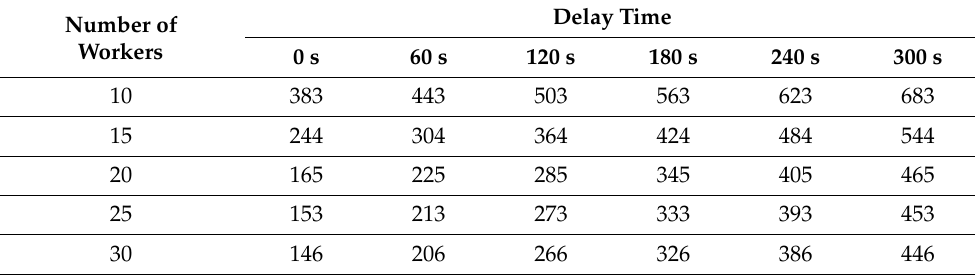
Table 7. Simulation results on required safe egress time (RSET).